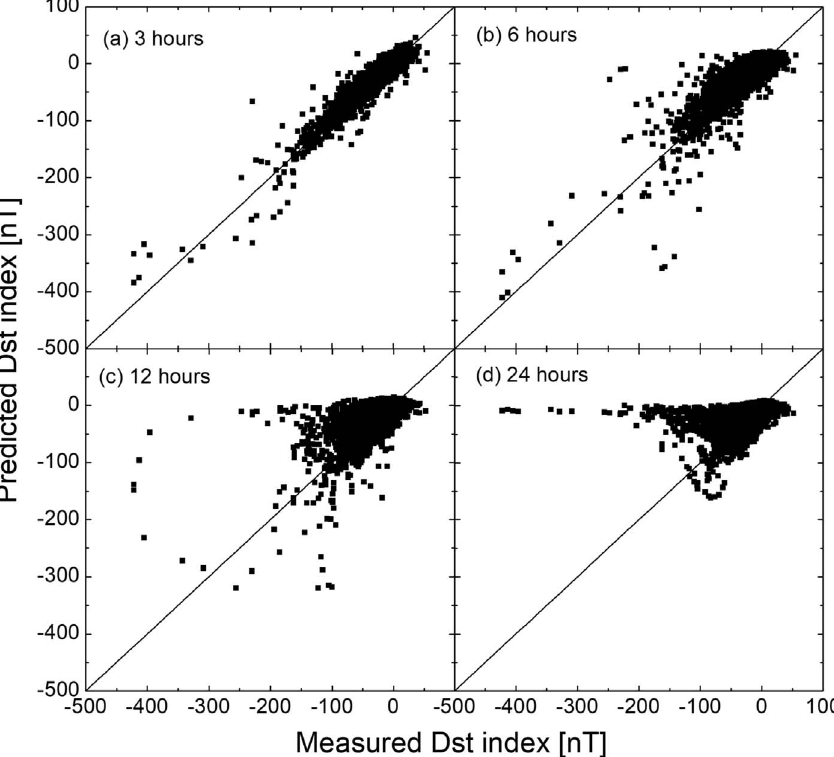
Fig. 11. Correlation between measured and predicted Dst index for (a) 3-hour (b) 6-hour, (c) 12-hour, and (d) 24-hour